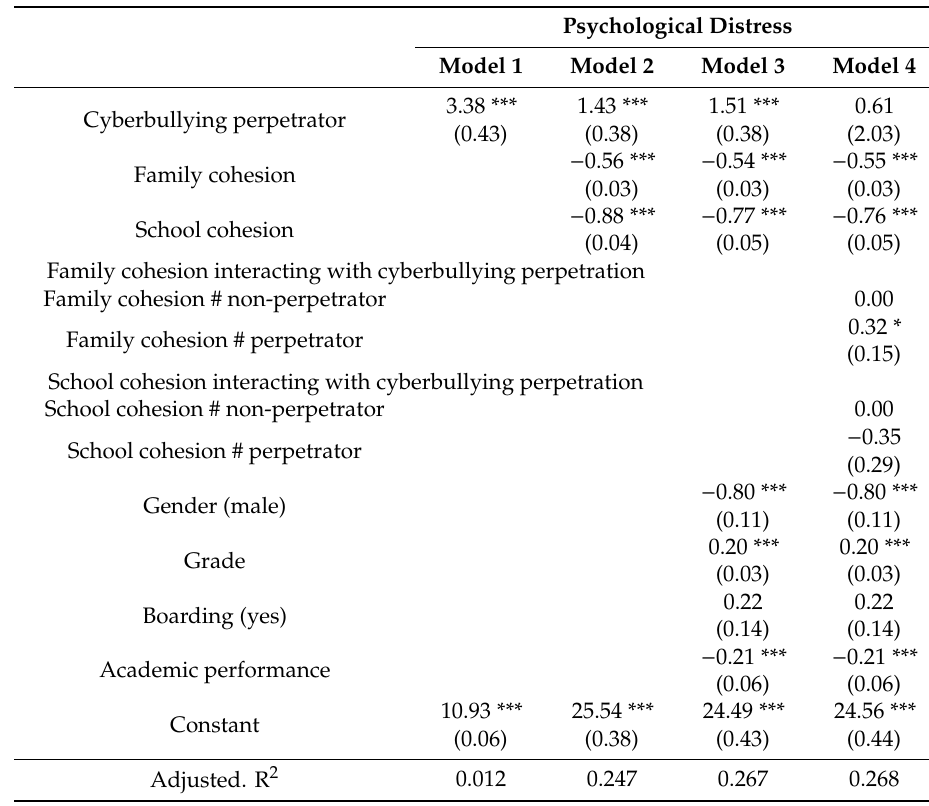
Table 3. Cyberbullying perpetration and psychological distress: the moderating e ff ects.